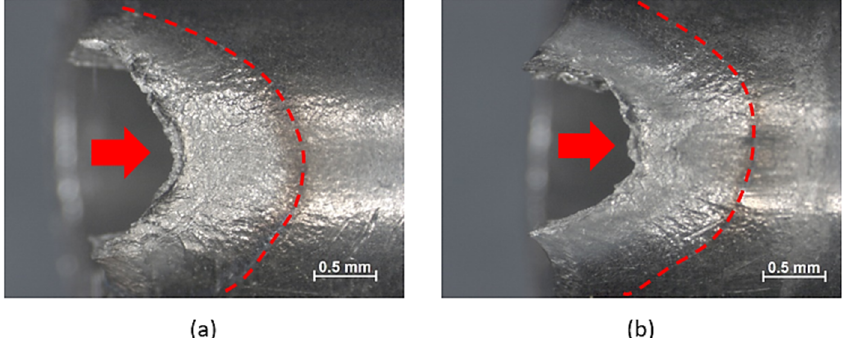
Figure 8. Fractured surfaces after tensile test for two representative cases: ( a ) SLM and ( b ) EBM.